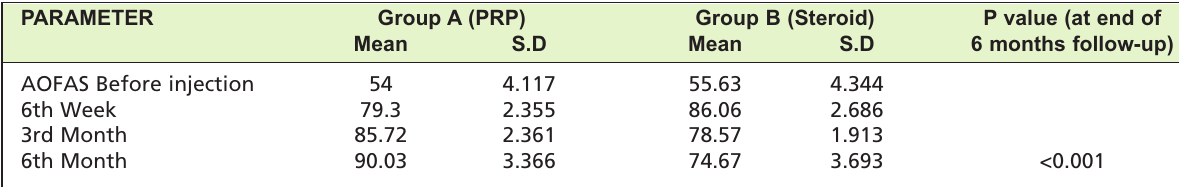
AOFAS (mean) in both groups Table III: